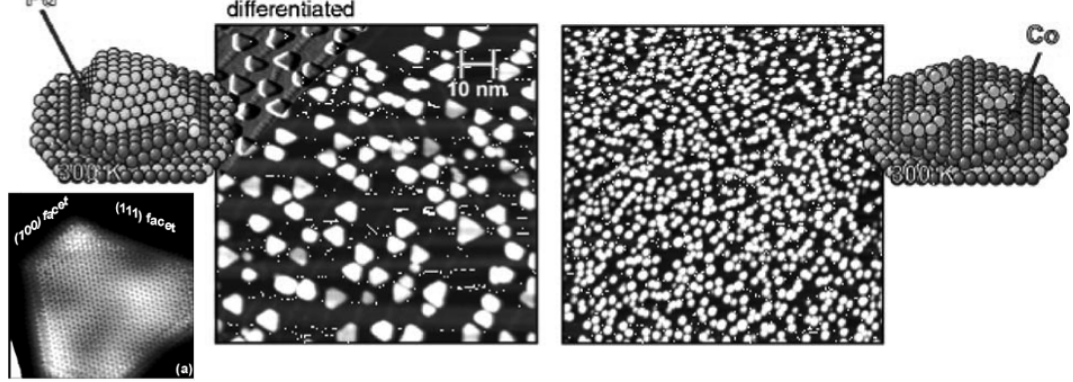
Fig. 16 – Sequential deposition of Co and Pd and vice-versa onto a thin alumina film at 300 K. The ball models schematically show the structure of the systems investigated: gray: NiAl substrate; blue: Al 2 O 3 film; light blue: defects of the alumina film; yellow: Pd atoms; orange: Co atoms (Hansen et al. 1999, Heemeier et al. 2002).